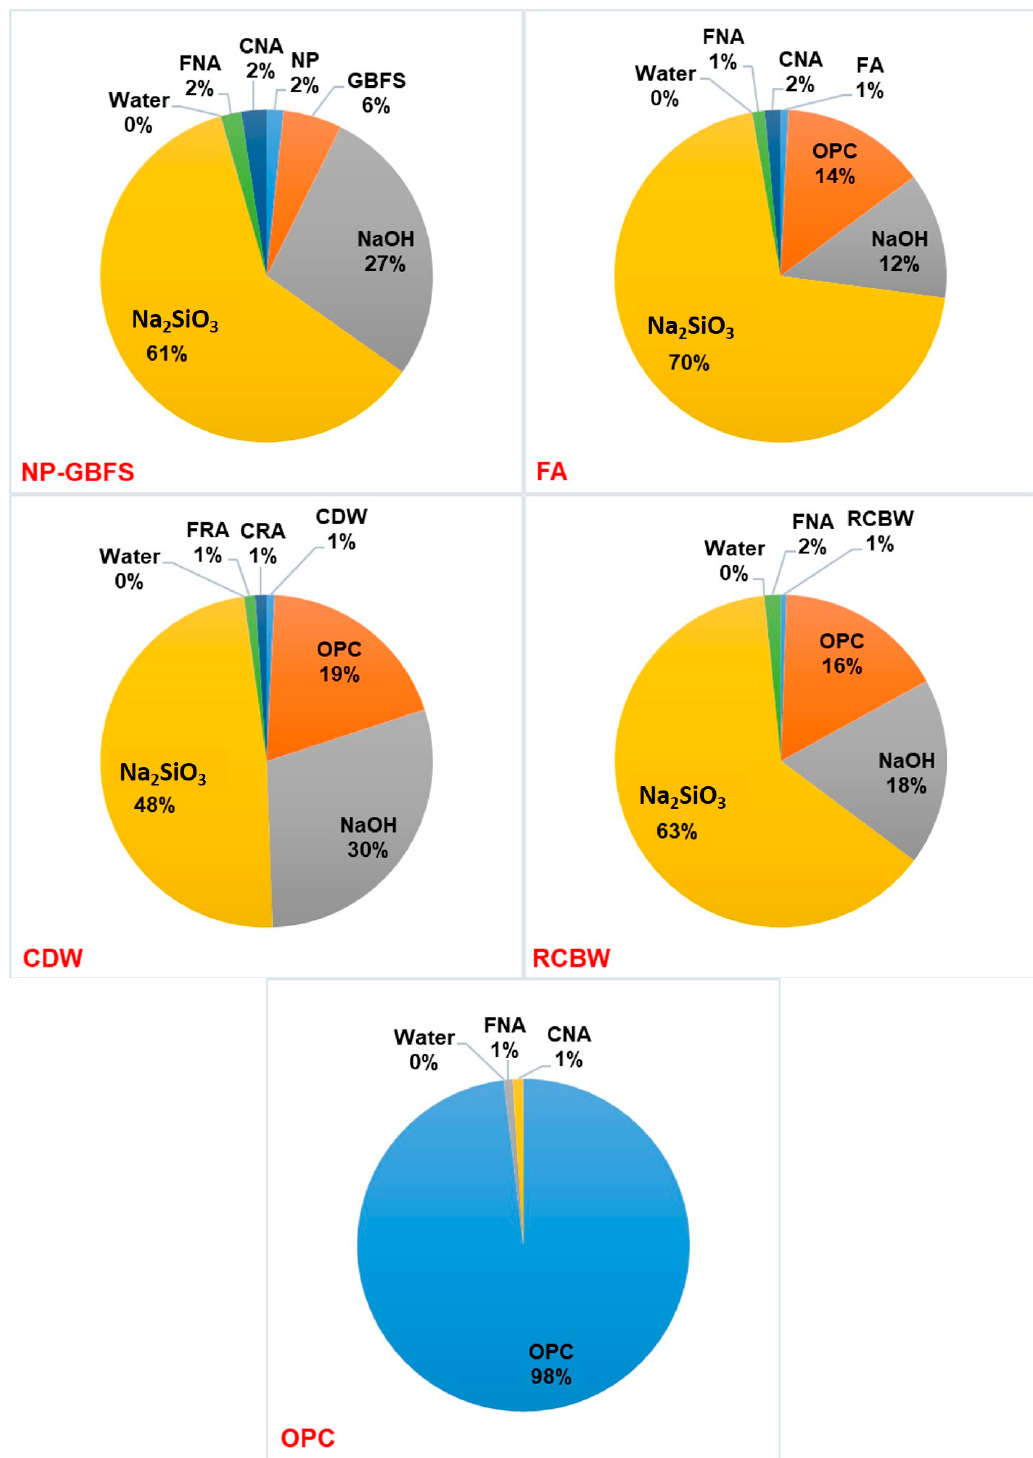
Figure 9. Contribution (%) of raw materials in the carbon footprint (GWP: kg ∙ CO 2 ∙ eq/m 3 ) of the concrete mixes and/or blocks produced (alkali-activated blocks vs. OPC block).